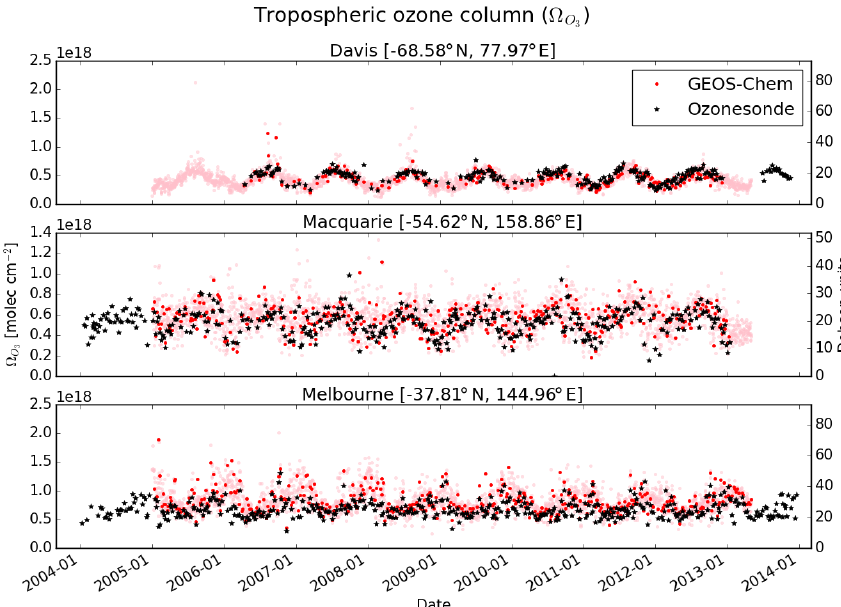
Figure 9. Comparison between observed (black) and simulated (pink, red) tropospheric ozone columns ( (cid:127) O 1 January 2004 to 30 April 2013. For the model, daily output is shown in pink, while output from days with ozonesonde measurements are shown in red. For each site, the model has been sampled in the relevant grid